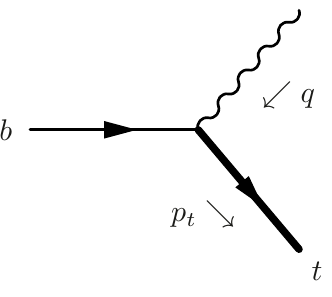
Figure 5 . LO diagram for single top quark production. We show only the part relevant for corrections associated with the heavy quark line. The thick solid line denotes the top quark. The wavy line denotes the o(cid:11)-shell W boson that couples to the light quark line. method within the e(cid:11)ective (cid:12)eld theory framework, namely the convenient organization of di(cid:11)erent perturbative ingredients and the ease of recycling existing universal functions. For a small cut-o(cid:11) (cid:28) , integration of the unresolved distribution obtained from d; cut